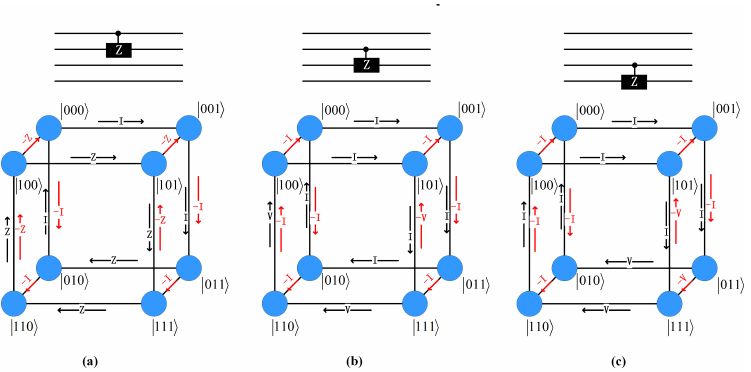
Figure 7. Implementation of ( a ) U 12 , ( b ) U 23 and ( c ) U 34 through 4-qubit quantum walk. Qubit 2, 3 CZ CZ CZ and 4 are used to determine the 8 positions in Hilbert space and actual CZ operation is performed on qubit 1. The operator on the arrow indicates the operation performed on the walker if the walker occupied the starting position of the arrow. The black arrows correspond to trace 1 while the red arrows correspond to trace